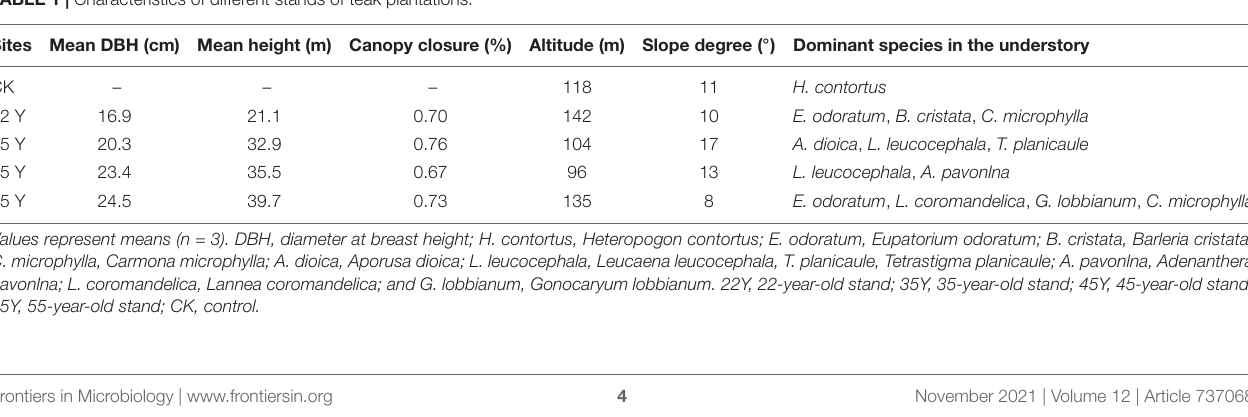
TABLE 1 | Characteristics of different stands of teak